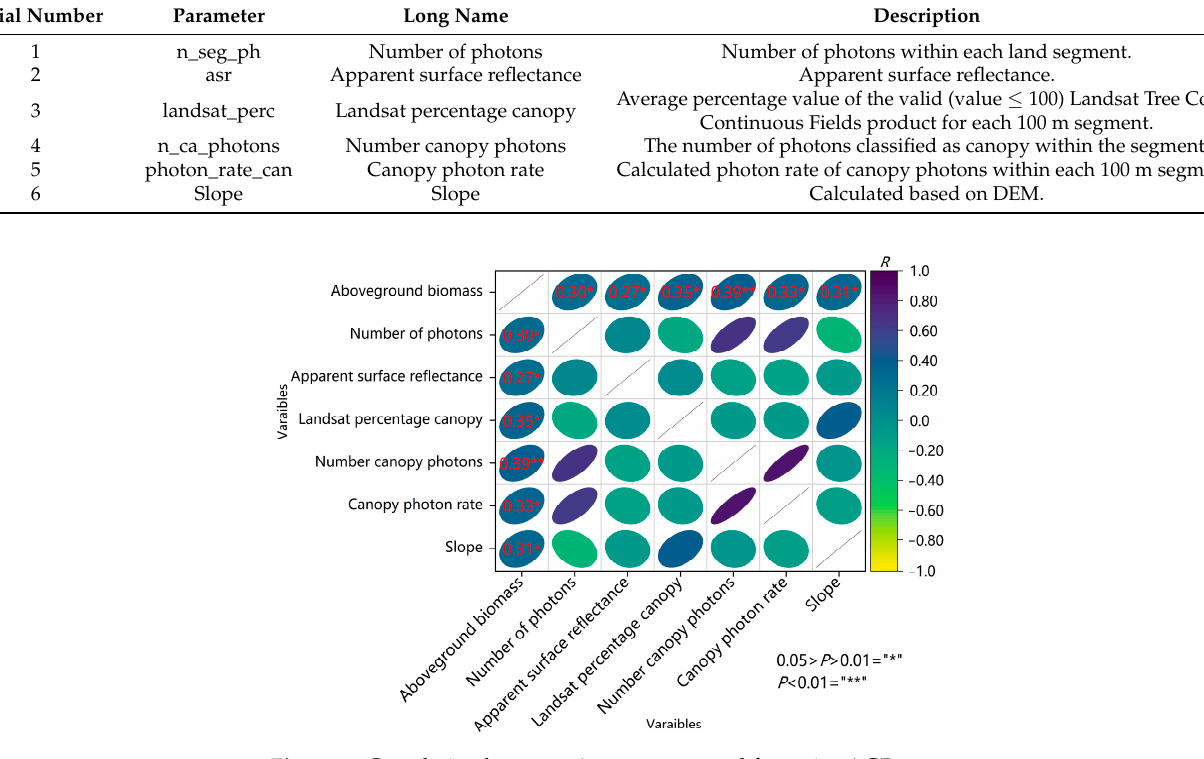
Figure 6. Correlation between 6 parameters and footprint AGB.